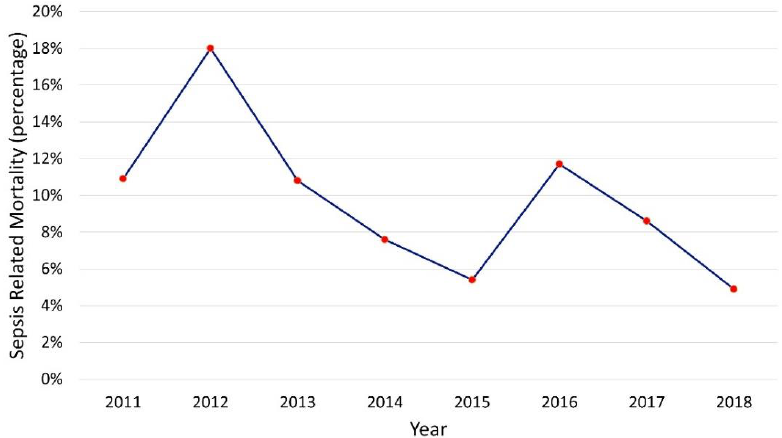
Figure 4. Sepsis mortality over time. Mortality attributed to sepsis did not change over time (R = −0.616, p = 0.104).